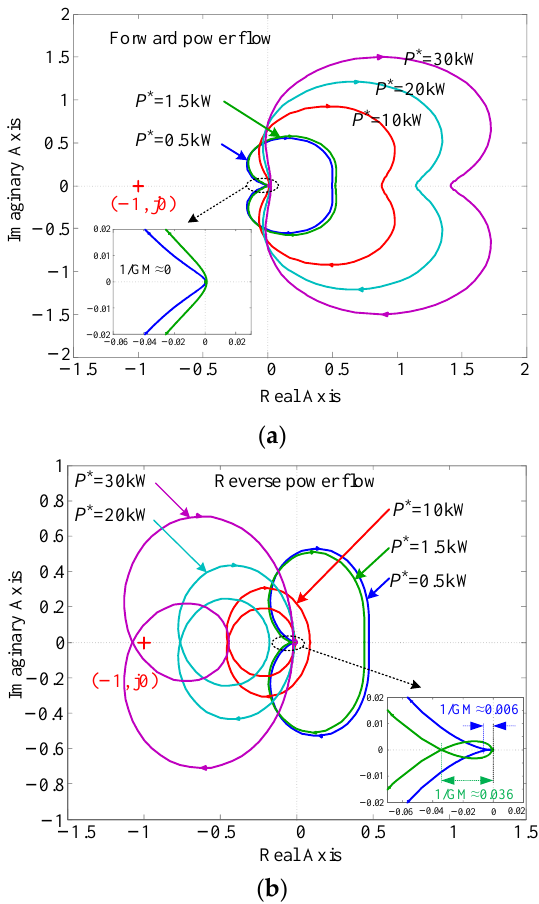
Figure 7. Nyquist plots obtained as power increases under conventional direct power control: ( a ) in